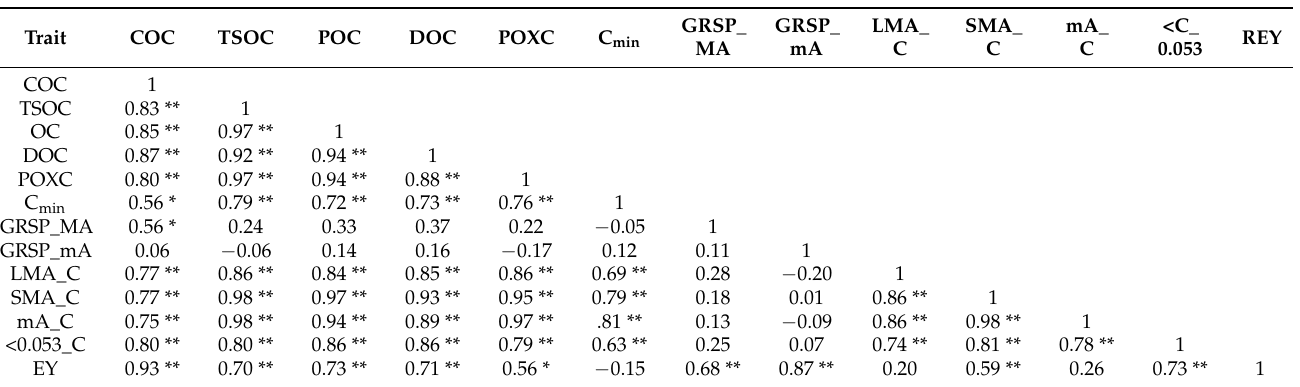
Table 5. Inter-relationships among different SOC fractions, aggregate-associated C, glomalin-related soil protein (GRSP) and rice equivalent yield